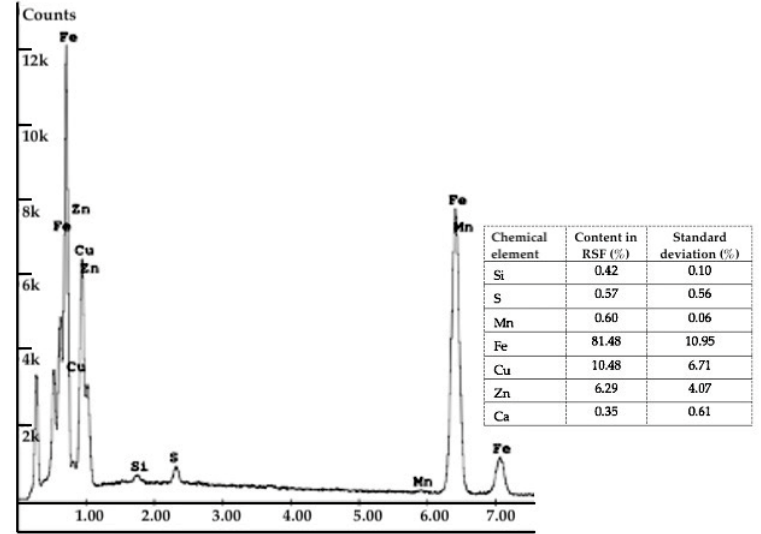
Figure 3. EDS spectrum for RSF recognised under X-ray analysis.